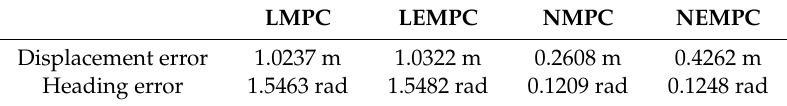
Figure 38. The computation time with the positioning error in ± 0.2 m. ( a ) LMPC. ( b ) LEMPC. ( c ) NMPC. ( d ) NEMPC. Table 8. The maximum absolute values with the positioning error in ± 0.2 m.